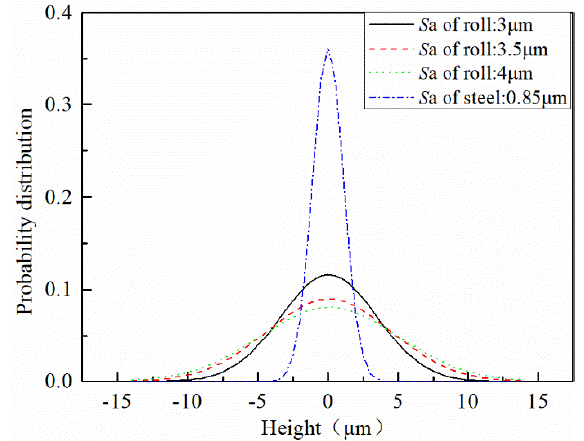
Figure 4. Probability distribution of roll and strip surface height.